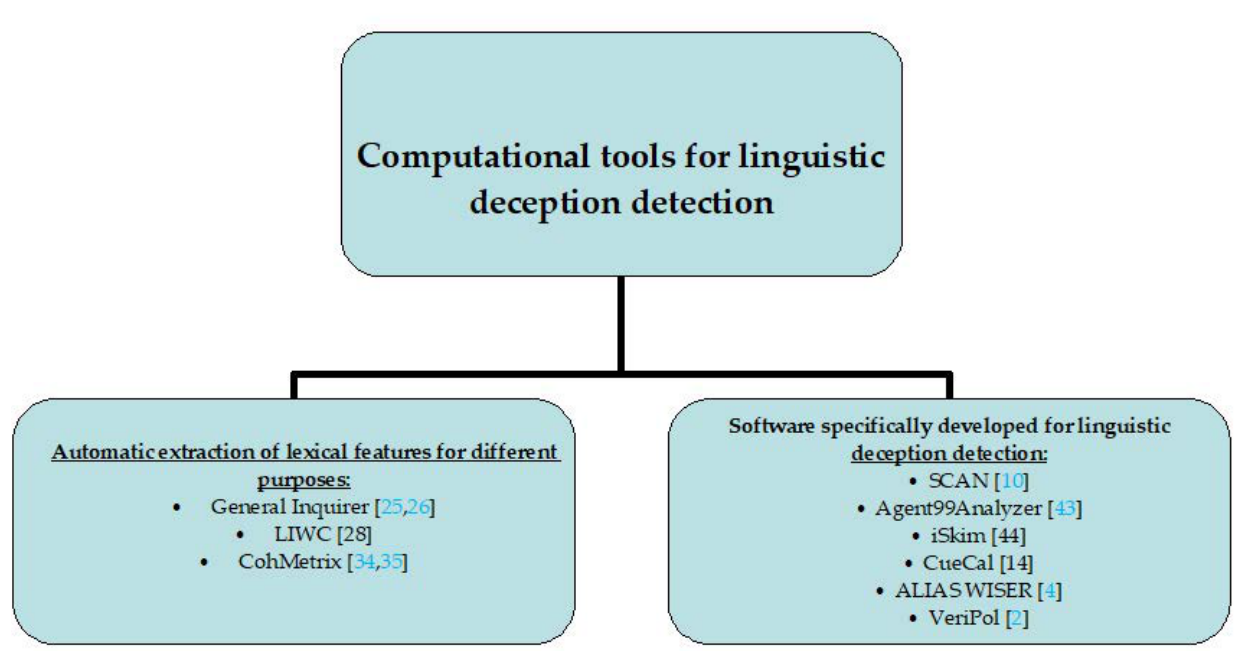
Figure 1. Schematic overview of the main computational tools for linguistic deception detection